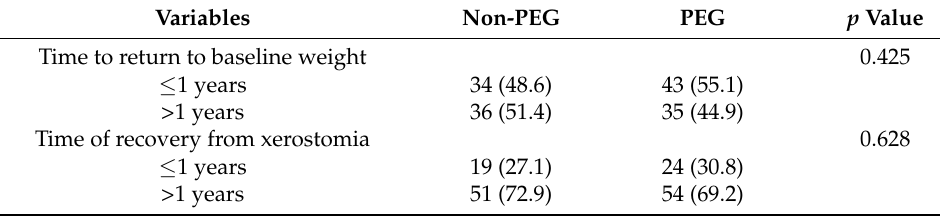
Table 4. Comparison of weight and xerostomia recovery between non-PEG and PEG